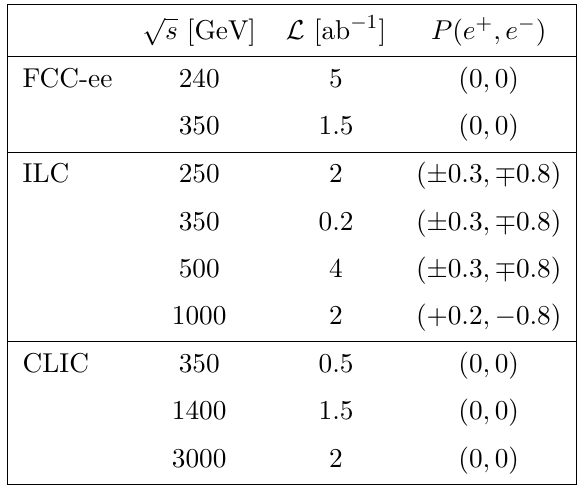
Table 4 . Di(cid:11)erent future collider run scenarios employed in ref. [37] for Higgs measurement prospects. Luminosities are equally split between two beam polarizations, when available. Note they di(cid:11)er slightly from the ones we used for top-quark, bottom-quark and muon pair production (see section